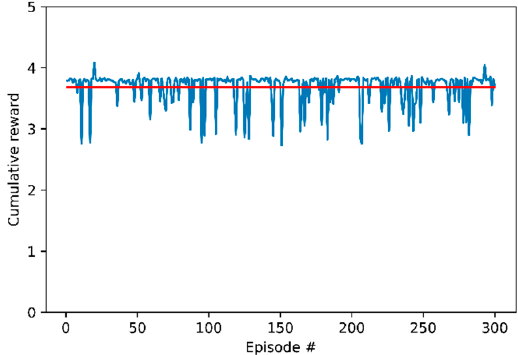
Figure 5. Cumulative reward in evaluation phase.